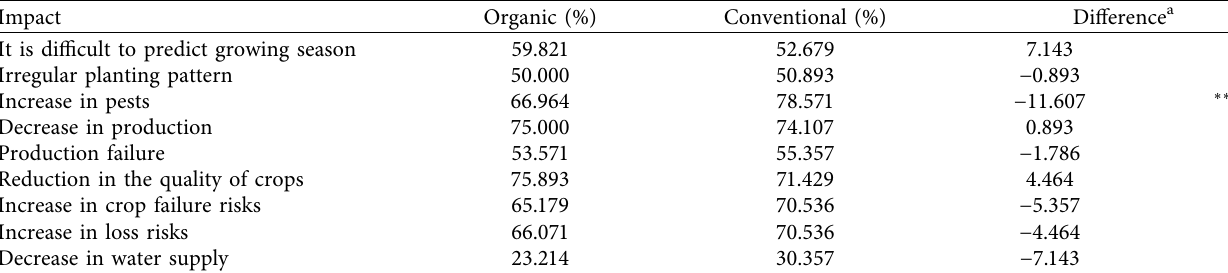
Figure 2: Organic and conventional vegetable farmers’ perceptions of changes in rainfall and temperature over the past 30 years in Java, Indonesia, 2018 (% of respondents). Table 3: Organic and conventional farmers’ perceptions of climate change impacts on vegetable